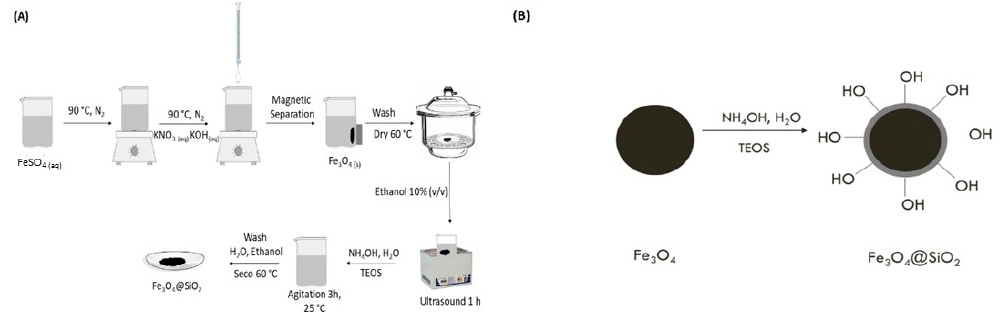
Figure 1. ( A ) Co-precipitation synthesis process of silica-coated magnetite. ( B ) Illustrative diagram of the magnetic core coating.